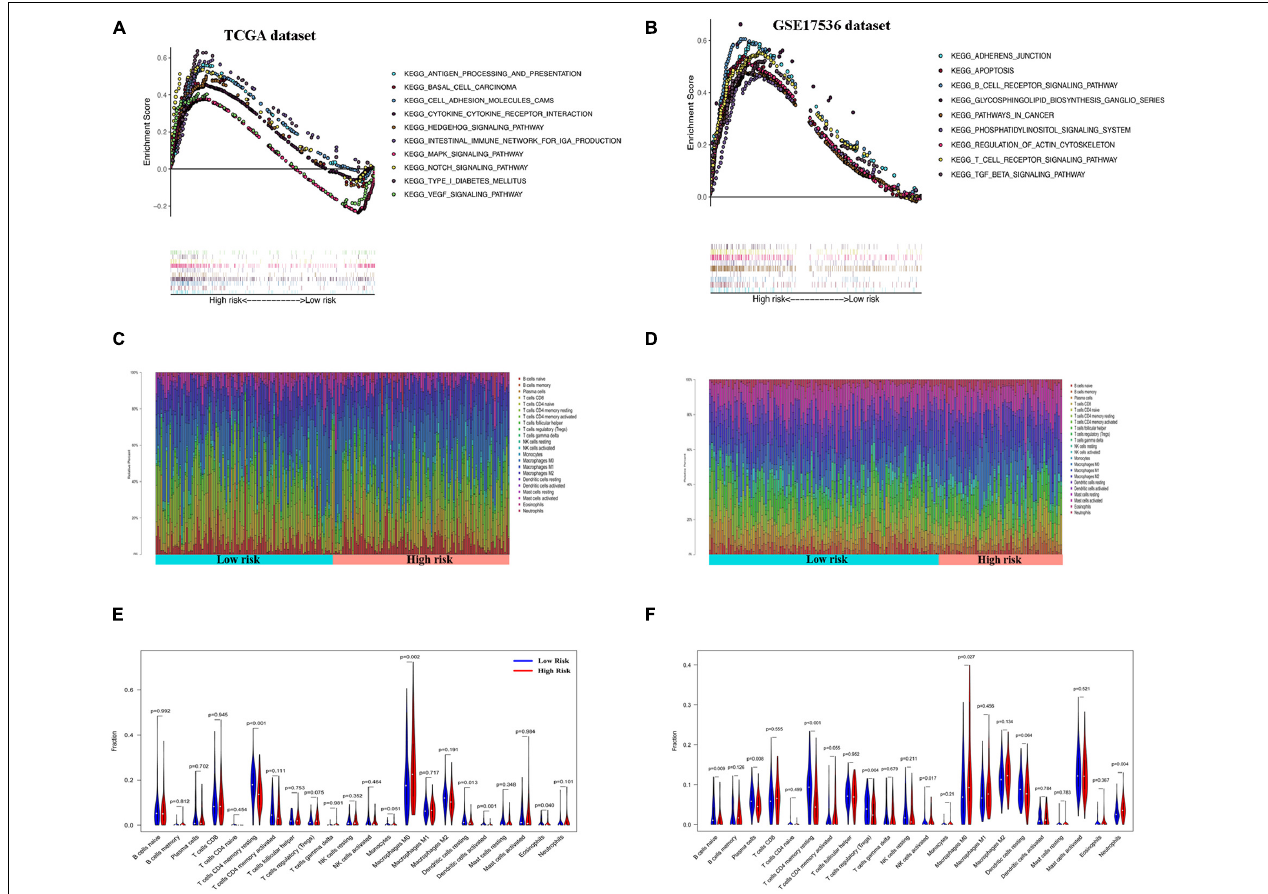
FIGURE 6 | Gene set enrichment analysis (GSEA) and immune cell infiltration analyses in low- and high-risk patients. (A,B) Kyoto Encyclopedia of Genes and Genomes (KEGG) enrichment of low- and high-risk groups by GSEA in The Cancer Genome Atlas (TCGA) cohort (A) and GSE17536 cohort (B) . Only gene sets with false discovery rate (FDR) q < 0.05 were considered significant. (C,D) Relative proportion of infiltrating immune cells in low- and high-risk colon adenocarcinoma (COAD) patients in TCGA cohort (C) and GSE17536 cohort (D) . (E,F) Comparative demonstration of the distinct infiltrating immune cells in low- and high-risk COAD patients in TCGA cohort (E) and GSE17536 cohort (F)